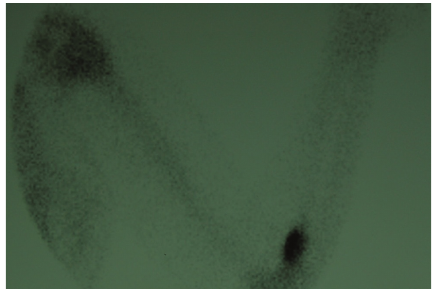
Figure2:BonescanimagewithTc 99 showingincreasedfocaluptake at the bicipital